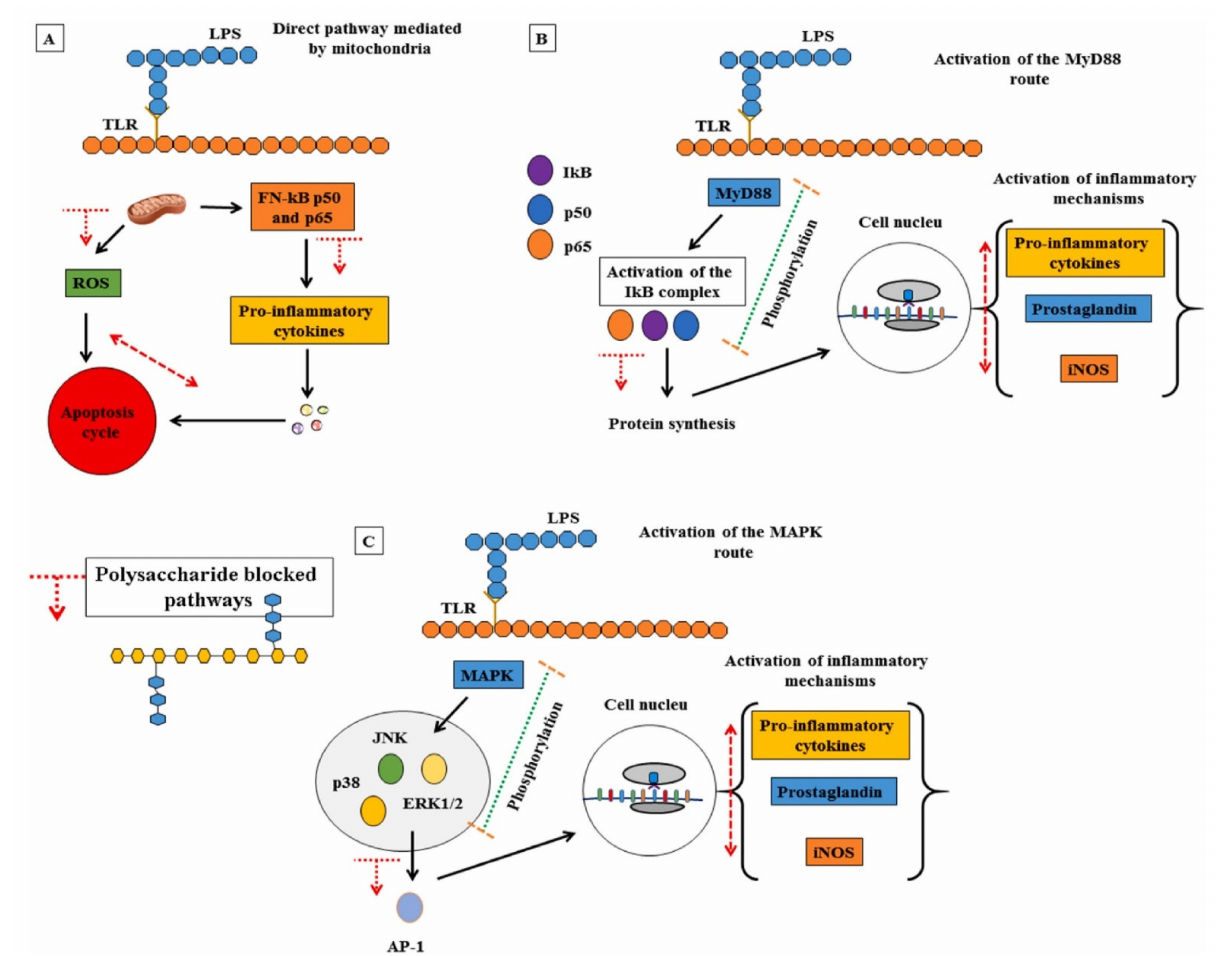
Figure 3. Major inflammatory pathways mediated by the immune system and polysaccharide signaling mechanisms that may contribute to immunosuppressive pro-inflammatory production pathways. ( A ) Direct route mediated by mitochondria; ( B ) MyD88 protein signaling